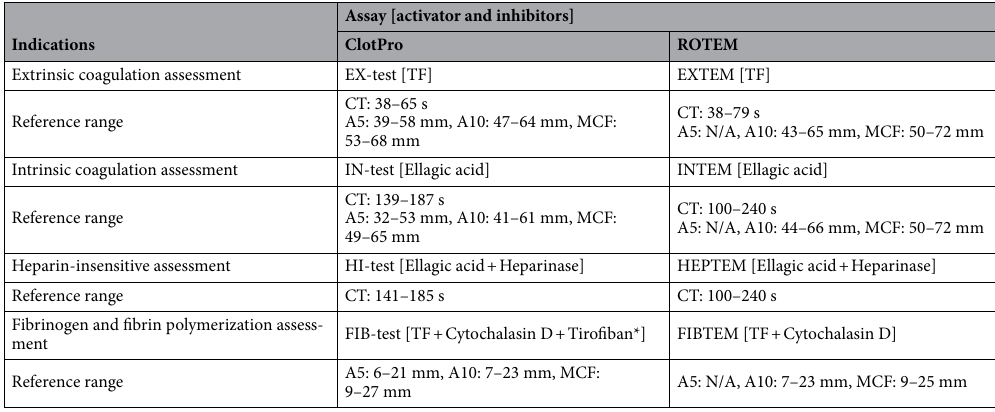
Table 1. ClotPro and ROTEM assays. TF tissue factor, CT clotting time, MCF maximum clot firmness, N/A not available. *Glycoprotein IIb/IIIa receptor